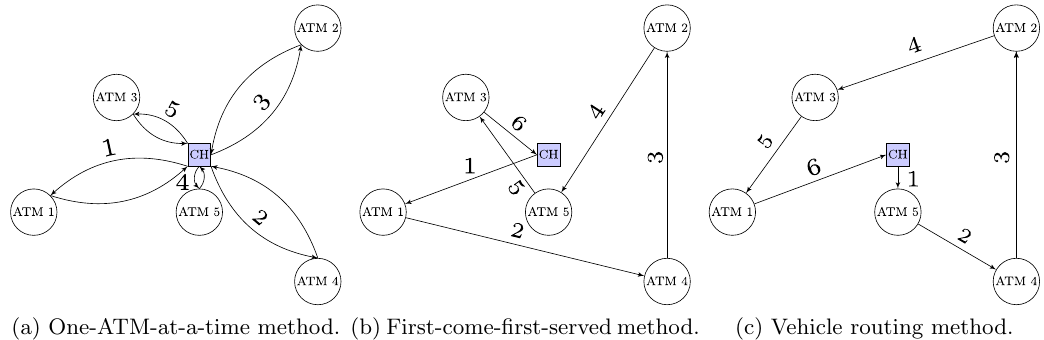
Figure 5: Three routing methods were used as part of the study. The method in (a) shows that an ATM is serviced when it requests service, and the vehicle returns to the CH on completion. ATM 1 first required service, then ATM 4, ATM 2, ATM 5, and ATM 3. In the case of the method in (b), the ATMs are served in the sequence they request service, but the return trips to the CH are eliminated, except for the last trip labelled ‘6’. The method in (c) shows application of a vehicle routing method: the requesting ATMs are served in the sequence determined by the route